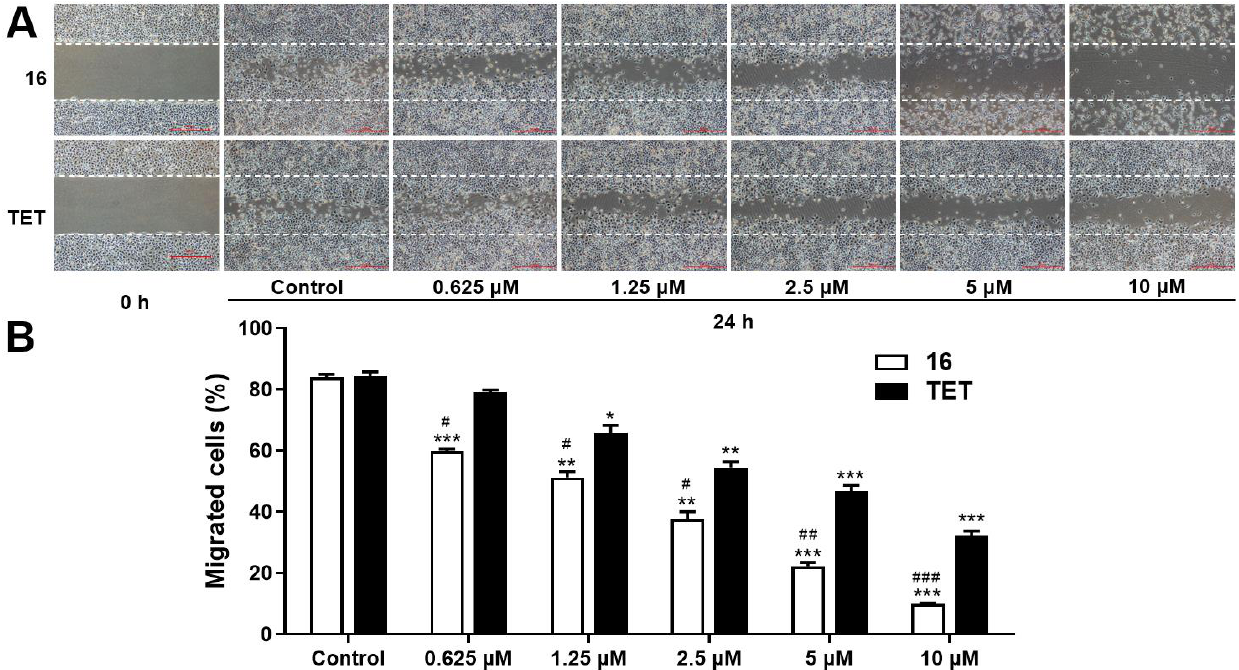
Figure 12. Inhibitory effect of 16 on the migration of HUVECs. ( A ) Photos of HUVECs migration inhibited by 16 (0.625, 1.25, 2.5, 5, and 10 μ M). ( B ) Statistical analysis of migrated cells calculated by ImageJ software. *: p < 0.05, **: p < 0.01, ***: p < 0.001, vs. control group; # : p < 0.05, ## : p < 0.01, ### : p < 0.001, vs. TET at the same concentration.